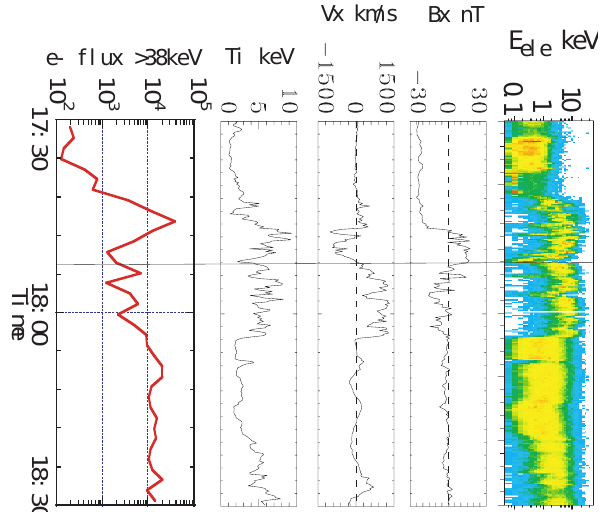
Fig. 26. The plasma sheet crossing data observed by Geotail on 10 December 1996. (Adopted from Hoshino et al.,